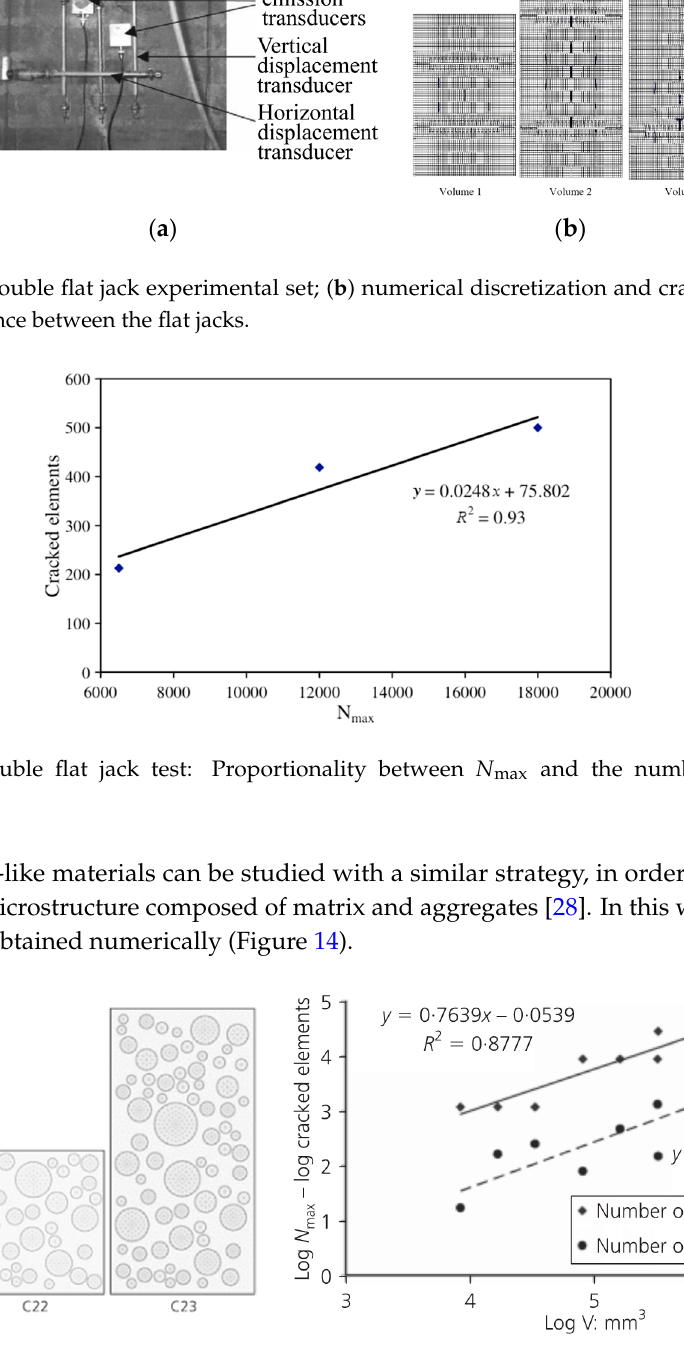
Figure 14. Compression tests: ( a ) sample meshes; ( b ) proportionality between N max and the number of cracked finite elements.